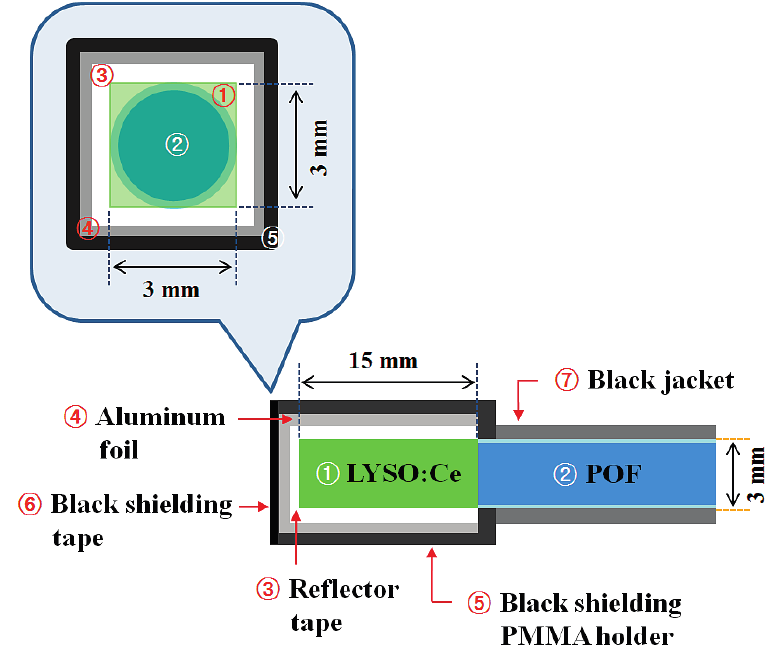
Figure 1. Schematic diagram of a sensing probe of a